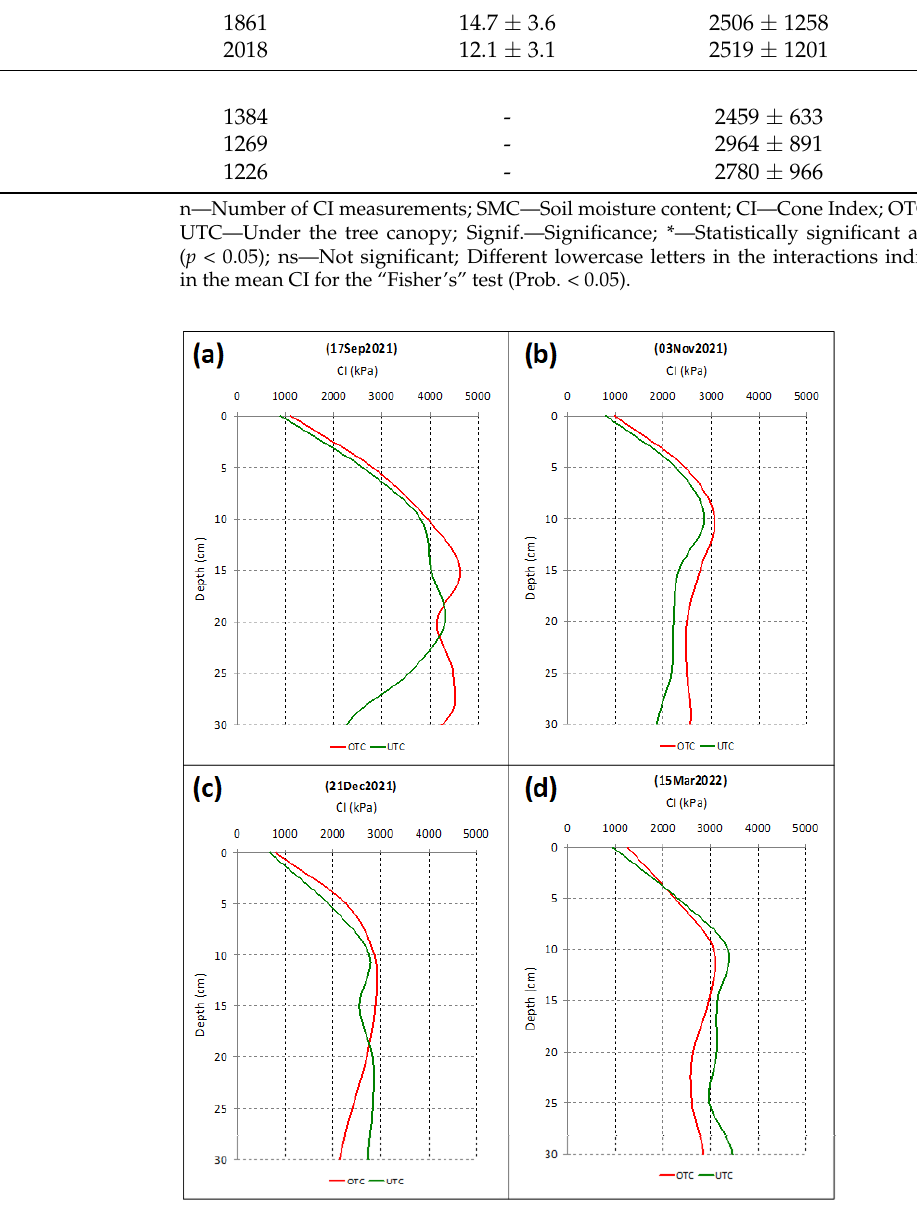
Figure 13. Average Cone Index (CI) at 0 – 0.30 m soil depth, outside and under the tree canopy (OTC and UTC, respectively): ( a ) 17 September 2021; ( b ) 3 November 2021; ( c ) 21 December 2021; ( d ) 15 March 2022.